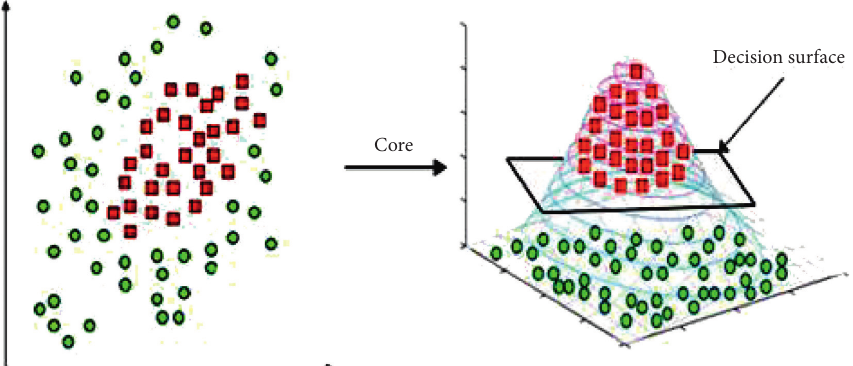
Figure 4: Support Vector Machine.